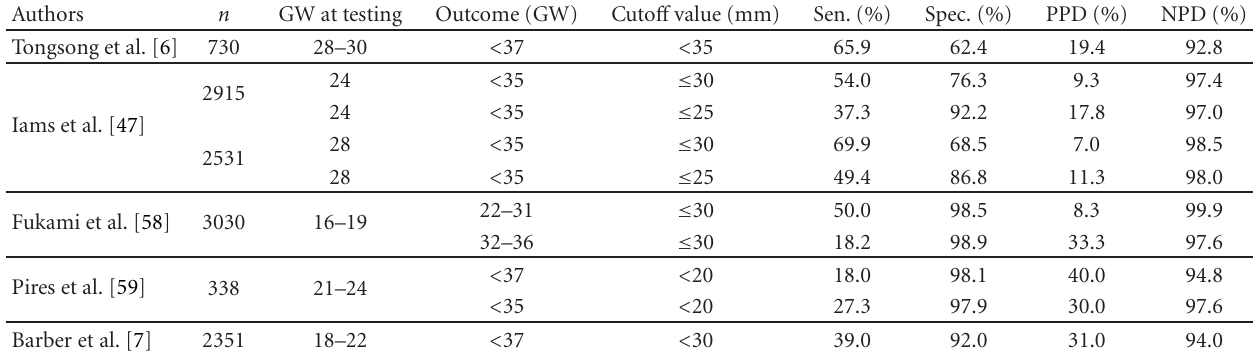
Table 2: Studies of CL measured by transvaginal ultrasonography to predict preterm birth in low-risk